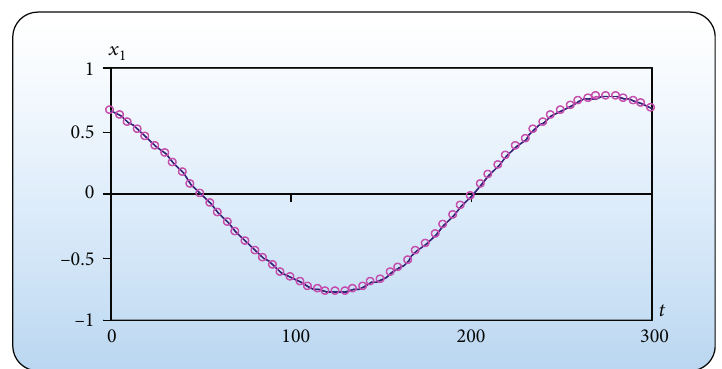
Figure 5: The analytical and numerical solutions x